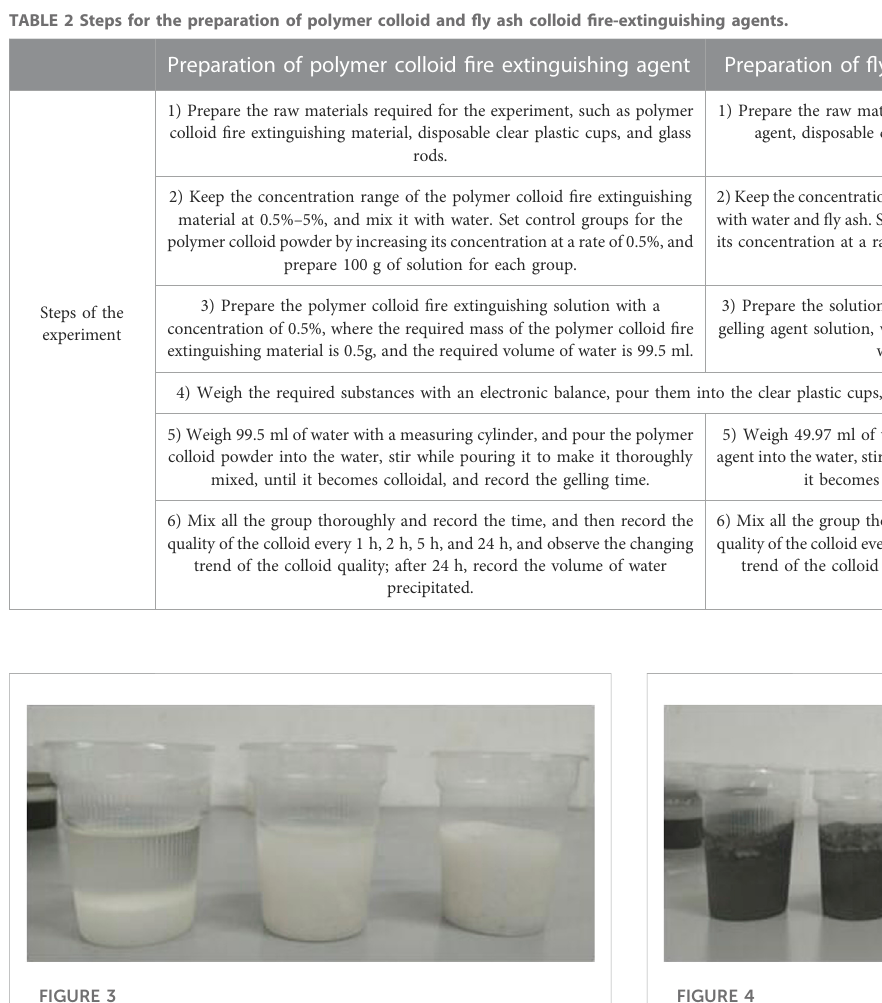
FIGURE 3 Comparison of water precipitation properties of the polymer colloid fi re extinguishing agent with different concentrations (From left to right, the concentrations of polymer colloid fi re extinguishing materials are 0.5%, 2.5% and 4.5%, respectively).